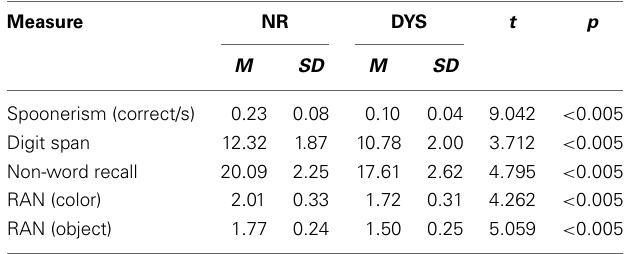
All p-values are Bonferroni adjusted for multiple